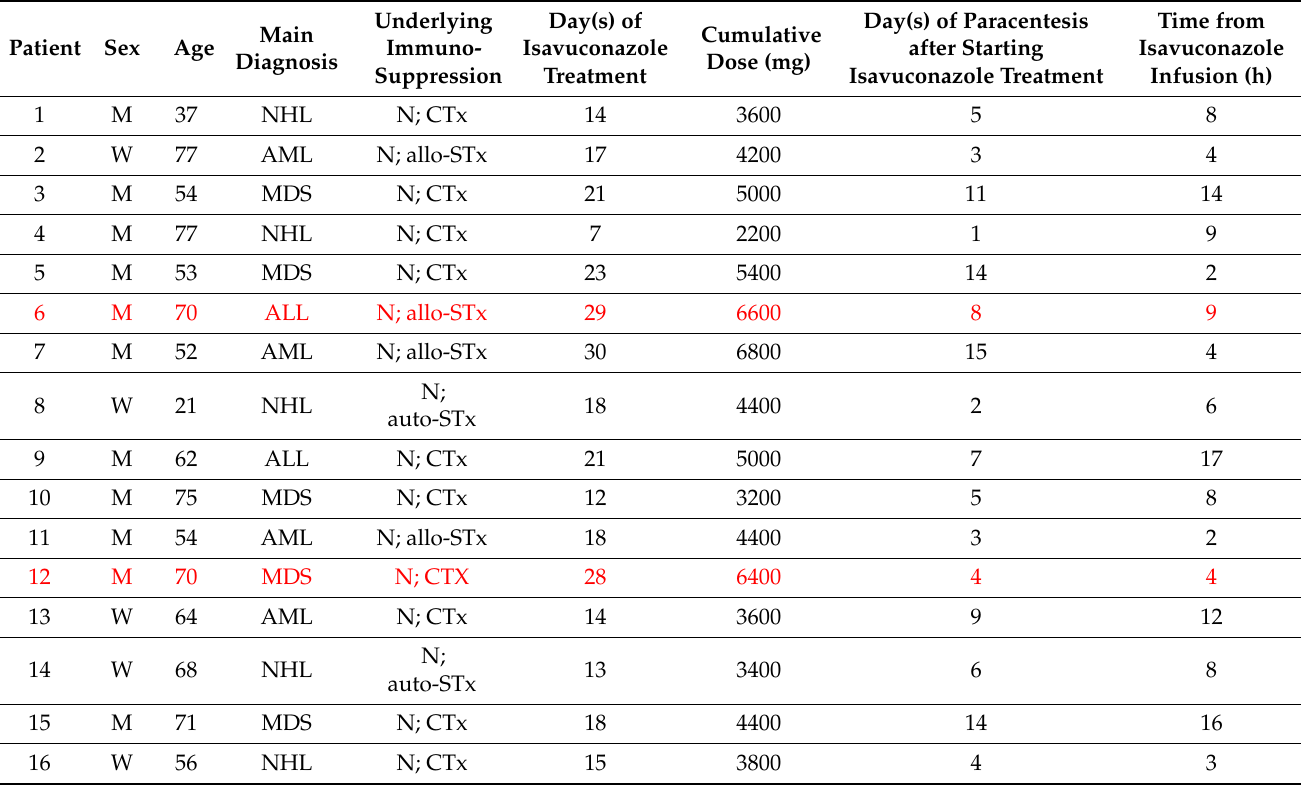
NHL = non hodgkin lymphoma; AML = acute myeloid leukaemia; MDS = myelodysplastic syndrome; ALL = acute lymphoid leukaemia; allo-Stx = allogenic stem cell transplantation; auto-STx = autologous stem cell transplantation; N = neutropenia; CTx = chemotherapy. Patients with IAC underlined in